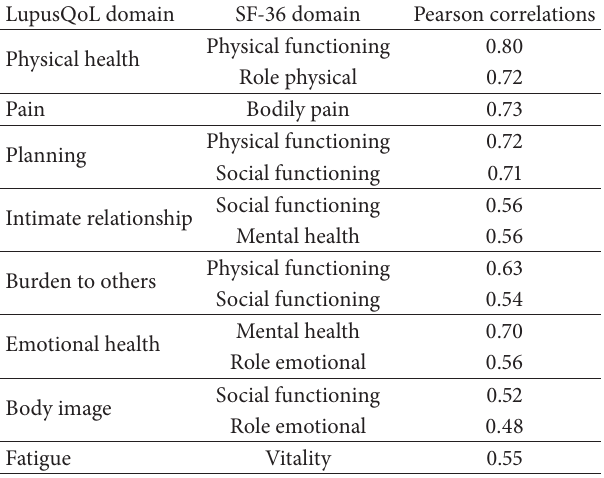
Table 3: Concurrent validity of the LupusQoL-P in comparison with the Short-Form Health Survey 36